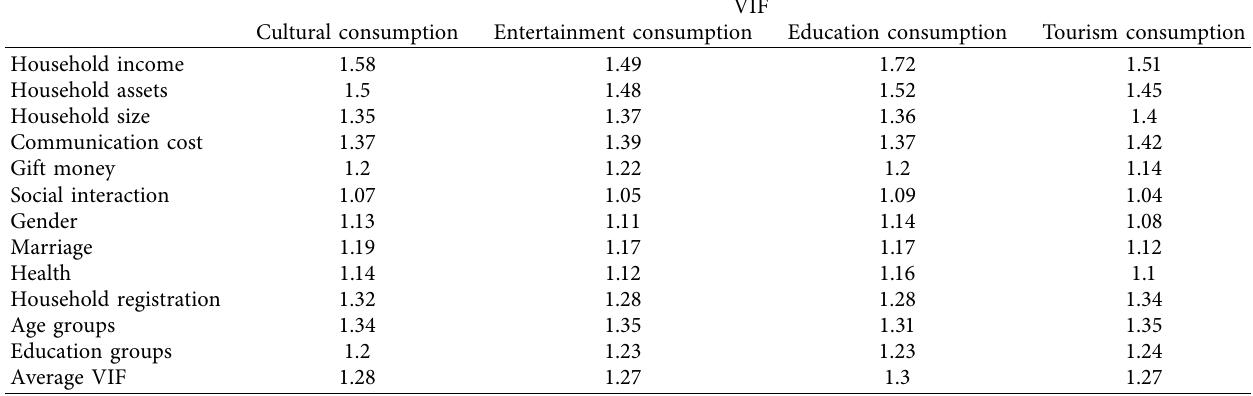
Table 5: Variance inflation factor test.